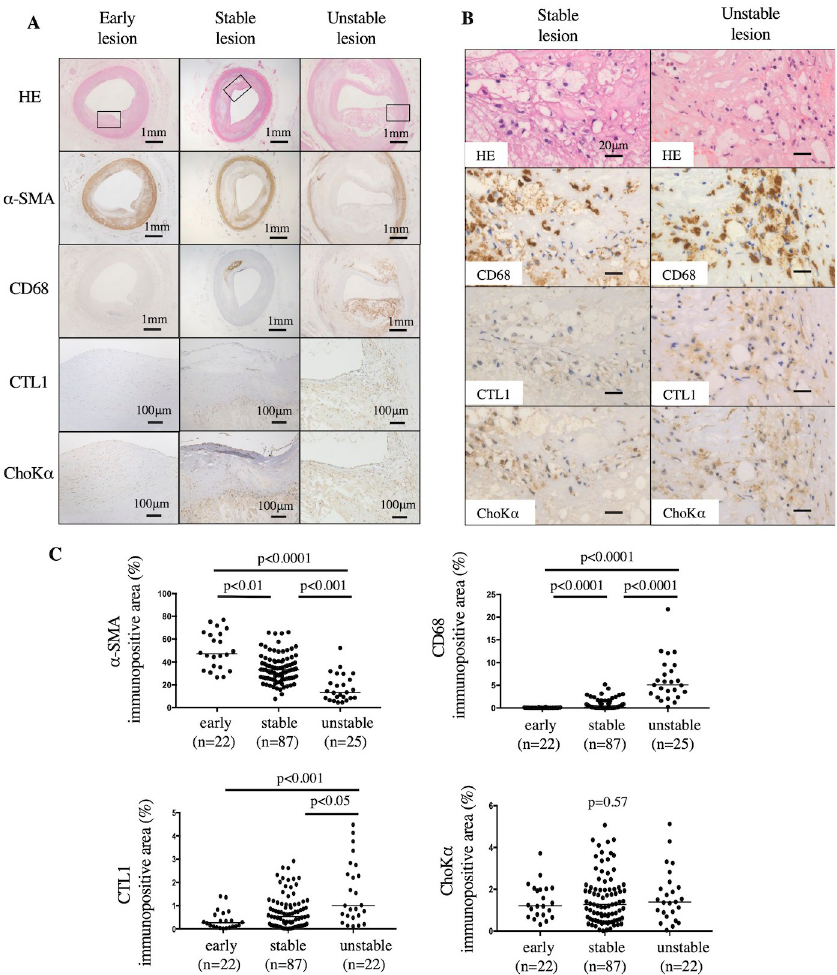
Fig 5. CTL1 and ChoK α expression levels in the human coronary artery. (A) Representative histological images of human coronary arteries stained with hematoxylin and eosin (HE) and antibodies for α -smooth muscle actin (SMA), macrophages (CD68), choline transporter-like protein 1 (CTL1), and choline kinase α (ChoK α ). Early lesions exhibited diffuse immunoreactivity for α -SMA and ChoK α in areas with intimal thickening. Stable lesions exhibited immunoreactivity for CD68 and ChoK α in the lipid core of the fibrous cap atheroma and focal immunoreactivity for α -SMA in the plaque. Unstable lesions exhibited immunoreactivity for CD68, CTL1, and ChoK α in thin-cap fibroatheromas and sparse α -SMA immunoreactivity in plaques. Squares in each image (HE-stained section) correspond to immunohistochemical images of CTL1 and ChoK α . Scale bars represent 1 mm or 100 μ m. (B) High- magnification images of HE and immunohistochemistry for CD68, CTL1, and ChoK α in stable and unstable plaques. CTL1 expression in CD68-positive macrophages was higher in unstable lesions than in stable lesions. ChoK α expression in macrophage-rich areas was comparable between stable and unstable lesions. Scale bars represent 20 μ m. (C) Immunopositive areas for α -SMA, CD68, CTL1, and ChoK α in human coronary arteries. α -SMA and CD68 immunopositive areas were measured in the whole arterial wall. CTL1- and ChoK α -immunopositive areas were measured in the most densely stained area in each plaque. α -SMA immunopositive area in early lesions (50.2 ± 15.9%), stable lesions (34.2 ± 12.5%), or unstable lesions (17.4 ± 11.8%). CD68 immunopositive area in early lesions (0.04 ± 0.05%), stable lesions (0.6 ± 1.0%), or unstable lesions (6.2 ± 4.7%). CTL1 immunopositive areas in early lesions (0.4 ± 0.4%), stable lesions (0.7 ± 0.7%), or unstable lesions (1.6 ± 1.3%). ChoK α immunopositive area in early lesions (1.4 ± 0.7%), stable lesions (1.5 ± 1.2%), or unstable lesions (1.9 ± 1.2%). Data are represented as mean ± standard deviation, and individual data points and median for each group. Data were analyzed using Kruskal-Wallis tests followed by Dunn’s multiple comparison tests.